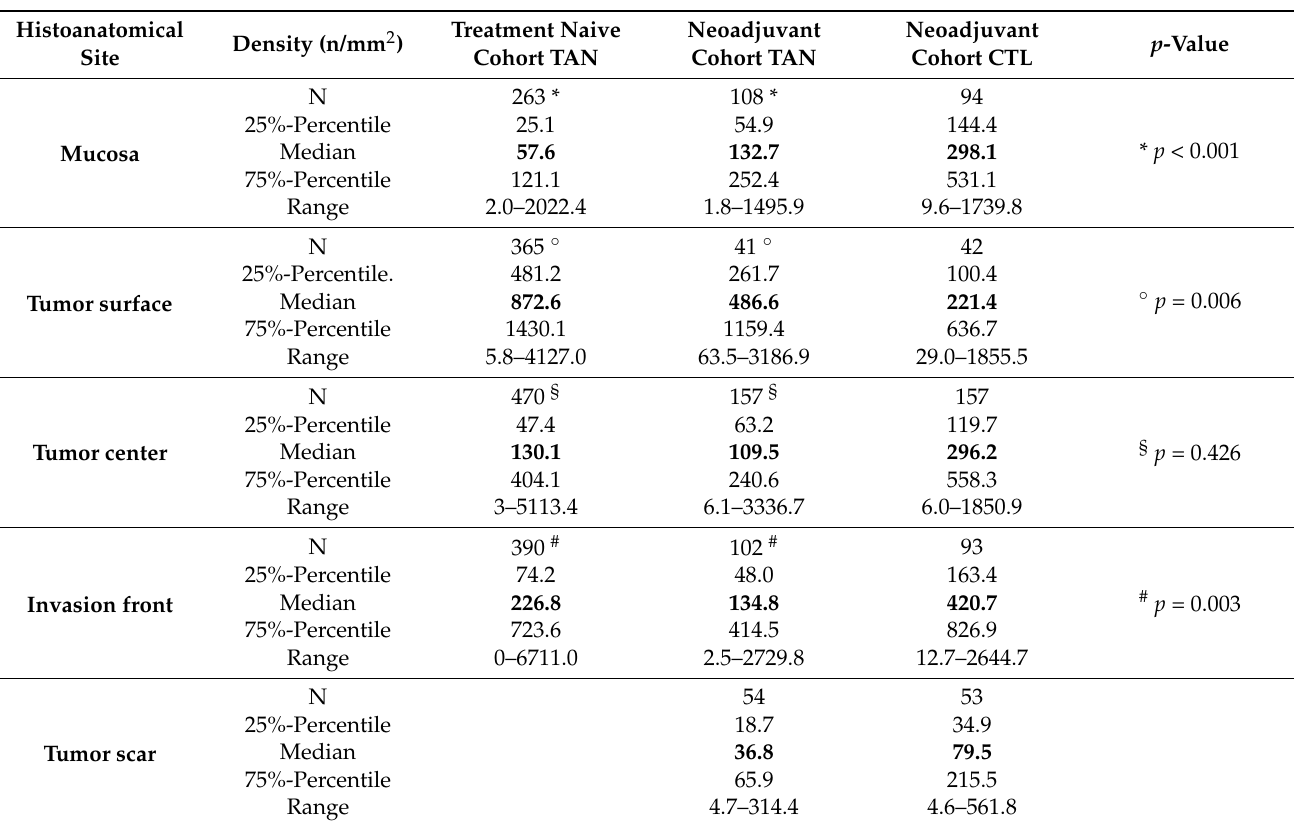
Figure 2. Digital image analysis. Digital image analysis was used to quantify the spatial distribution of tumor-associated neutrophils (TANs; A , D , E , F ) and cytotoxic T cells ( B ) in neoadjuvantly treated gastric cancer. The viewer and painting program VMP was used to mark the tumor compartments ( D ): mucosa (light blue), tumor surface (green), tumor center (yellow), invasion front (orange), and tumor scar (dark blue). The density was quantified by image analysis using Definiens Tissue Studio® (TANs identified by Definiens are marked as yellow points; F ). The same tumor is pictured in all figures. Anti-myeloperoxidase immunostaining ( A , D , E , F ); anti-CD8 immunostaining ( B ); hematoyxlin and eosin-staining ( C ). Table 2. Densities of tumor-associated neutrophils (TAN; naïve vs. neoadjuvant) and the densities of cytotoxic T cells (CTL) in five different compartments of gastric cancer . The median is marked in bold. The p -values denote the results of the Mann–Whitney test between the treatment naïve and the neoadjuvant cohort, as indicated by the superscribed prefix. The data for the treatment naïve cohort were retrieved from Clausen et al. [21]. CTL were not available from the treatment naïve cohort. The prefix symbols indicate which TAN data were analyzed statistically and to which the p -values correlated.